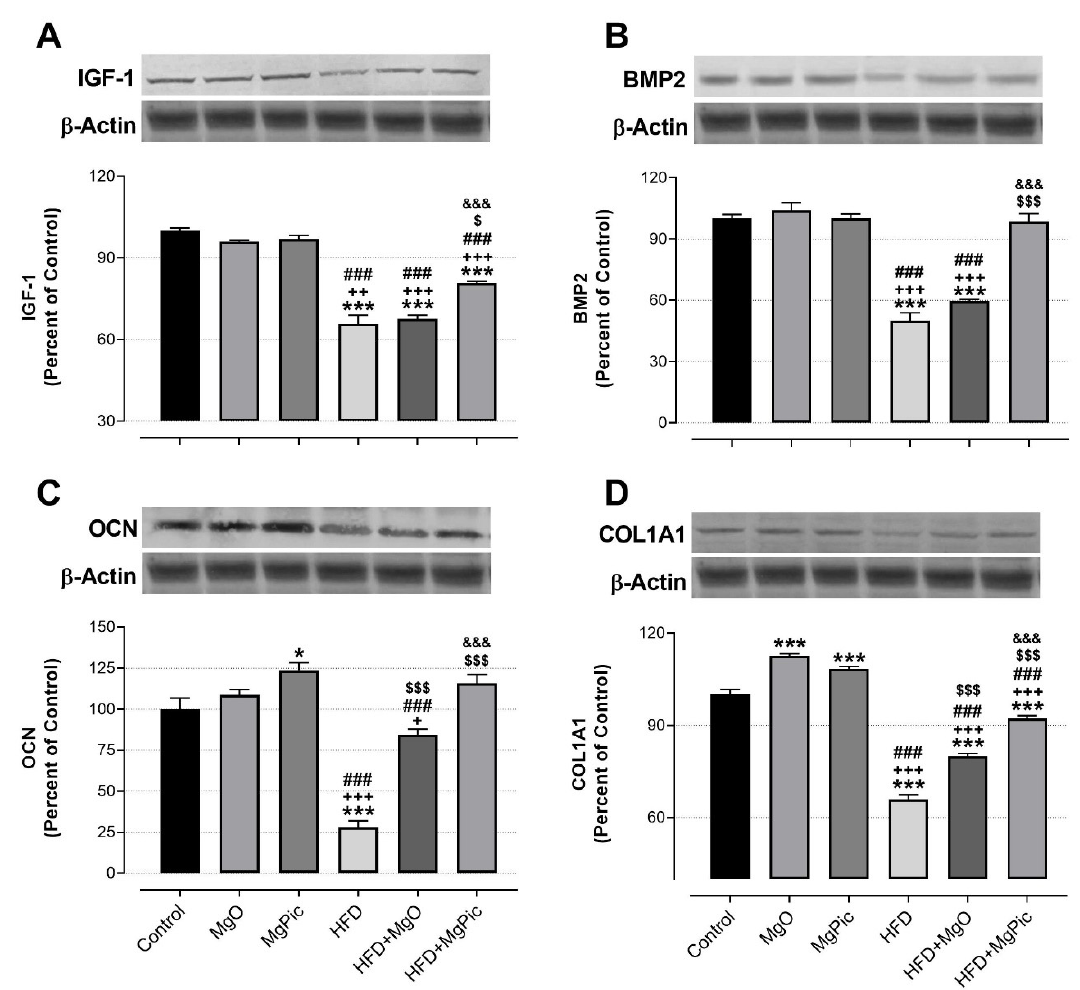
Figure 2. Effects of MgO or MgPic supplementation on bone ( A ) IGF-1; ( B ) BMP2; ( C ) OCN; ( D ) COL1A1 levels in rats. Blots were repeated at least three times, and β -actin was used for loading control. The blots were cropped, and full-length blots are presented in Supplementary Figure S2. Data (percent of the control group) are shown as mean ± standard error of the mean. Different symbols indicate the statistical difference between groups (* p < 0.05 and *** p < 0.001 as compared with the control group; + p < 0.05, ++ p < 0.01, and +++ p < 0.001 as compared with the MgO group; ### p < 0.001 as compared with the MgPic group; $ p < 0.05 and $$$ p < 0.001 as compared with the HFD group; &&& p < 0.001 as compared with the HFD + MgO group). One-way ANOVA and Tamhane’s T2 (IGF-1) or Tukey’s (BMP2, OCN, and COL1A1) post hoc tests were used for statistical analysis.